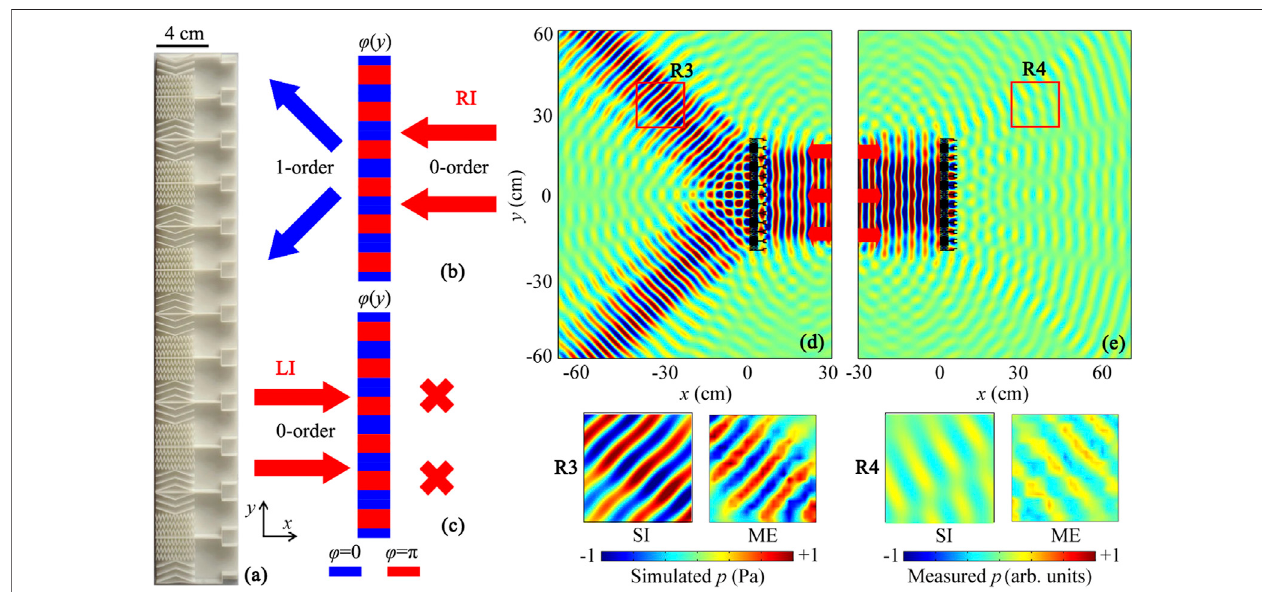
FIGURE5|(A) PhotographoftheUAIlenscomposed of12phased units. Each phased unit isplacedclosetogether.Schematicofpropagation paths through the UAI lens under the incidence of the zero-order wave for (B) RI and (C) LI. Simulated pressure distributions created by the UAI lens under the incidence of the zero-order wavefor (D) RIand (E) LIat7.1 kHz.Redsolidarrowsin (B) – (E) aretheincidentwave.Fourinsetsonthebottomarethesimulatedandmeasuredintensitydistributionsin red open squares R3 and R4.